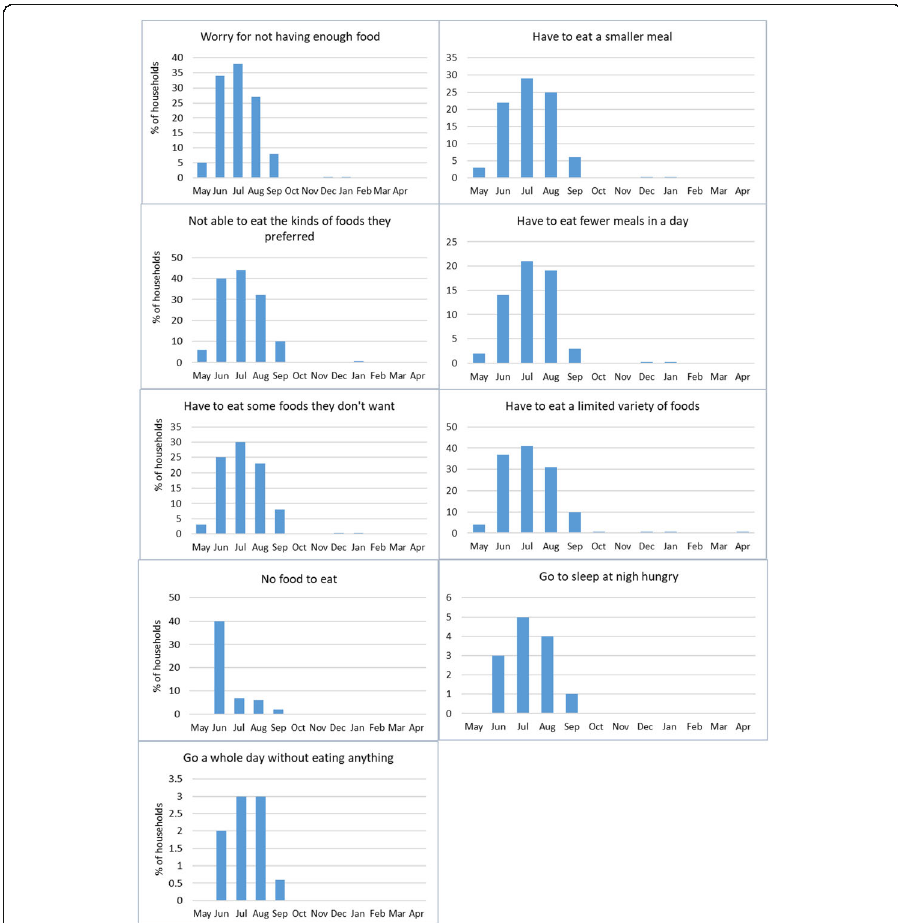
Fig. 9 Months of inadequate household food provisioning. Source: Authors ’ computation using study survey